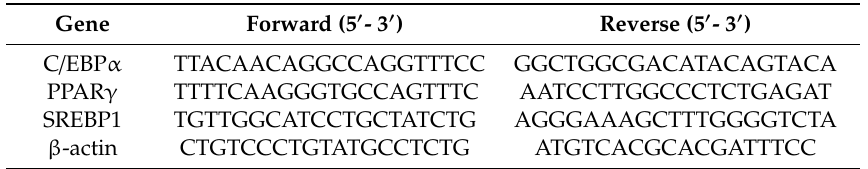
Table 1. Primer sequences for quantitative real-time PCR. Gene Forward (5 (cid:48) - 3 (cid:48) ) Reverse (5 (cid:48) - 3 (cid:48)